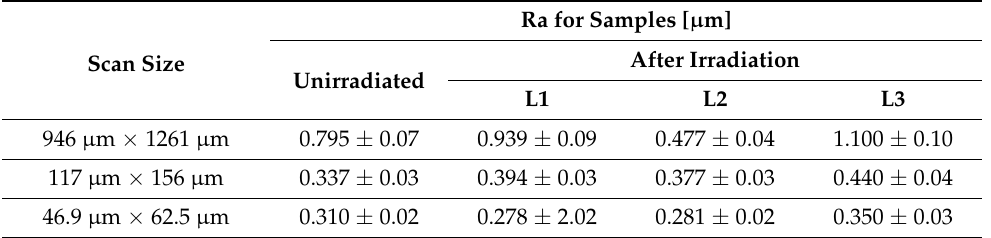
Table 6. The roughness parameters for the zirconia samples before and after irradiation.